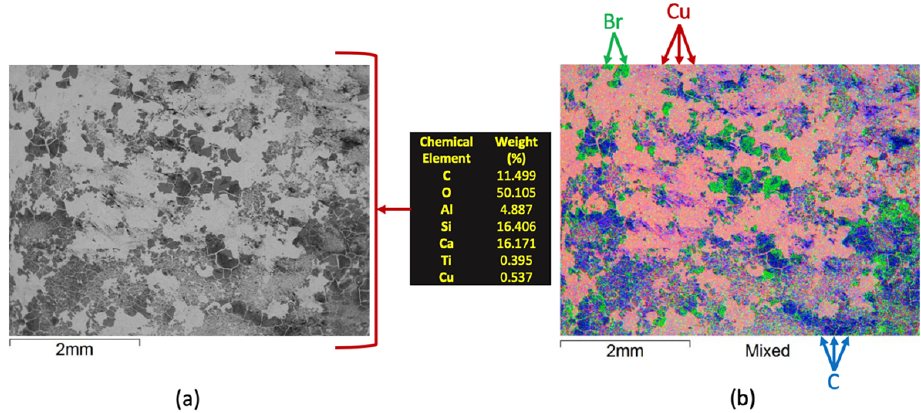
Figure 13. SEM/EDS characterization of the copper sheets recovered after the size separation: ( a ) Backscattered Electrons Image with microanalysis; ( b ) chemical mapping.